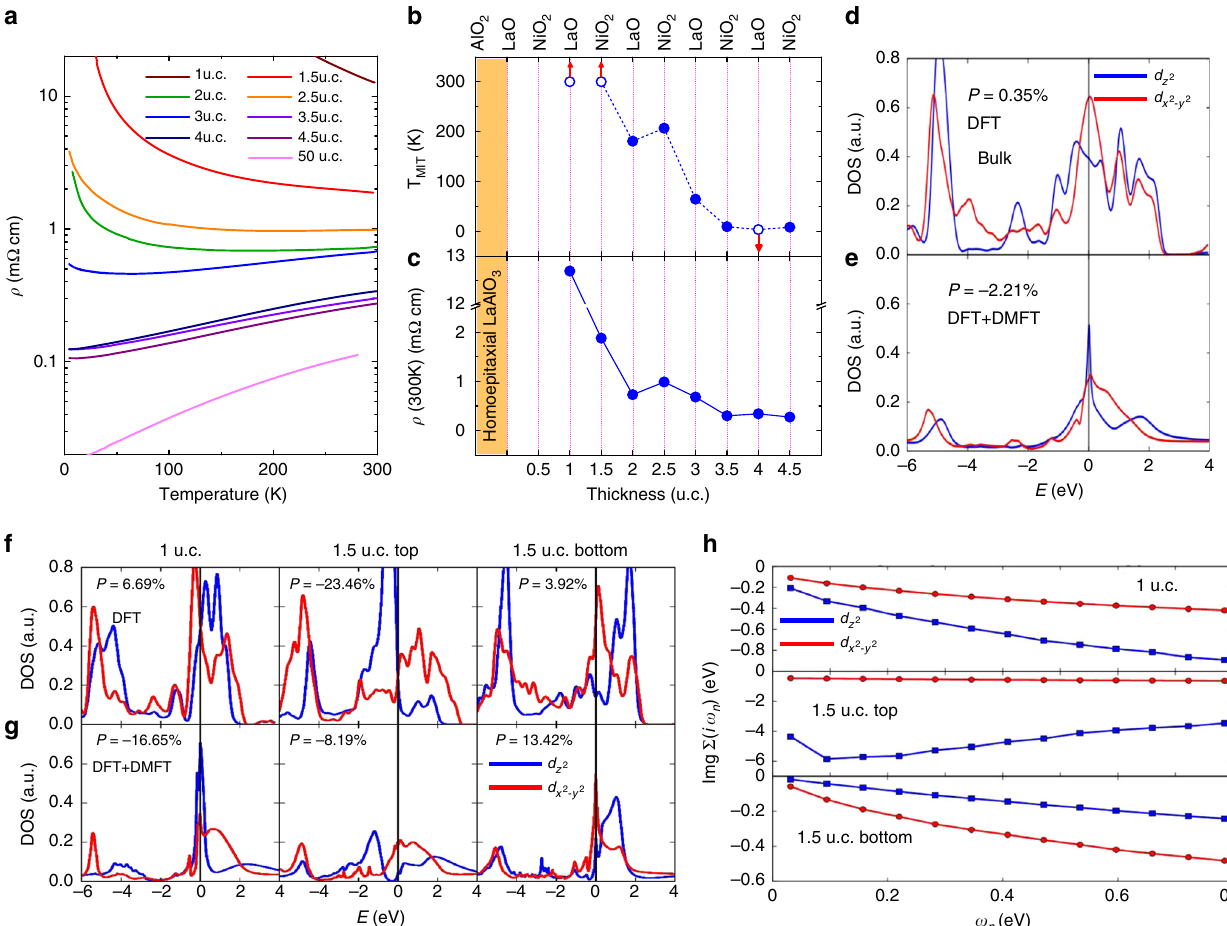
Fig. 2 Metal-insulator transition in ultrathin LaNiO 3 fi lms. a Temperature-dependent resistivity ( ρ ) of LaNiO 3 fi lms of different thicknesses. b Metal- insulator transition temperature T MIT and c ρ (300 K) of LaNiO 3 fi lms with different thicknesses and surface terminations. Open circles indicate that no MIT was observed in the temperature range studied. d DFT and e DFT + DMFT calculations of the DOS of the Ni 3 d orbitals for bulk LaNiO 3 on the compressive LaAlO 3 substrate. f DFT and g DFT + DMFT calculations of the DOS for 1 u.c. and 1.5 u.c. LaNiO 3 thin fi lms on the compressive LaAlO 3 substrate. The orbital polarization P for each case is indicated. h The imaginary part of the DMFT self-energies of Ni e g orbitals on the Matsubara frequency for 1 u.c.